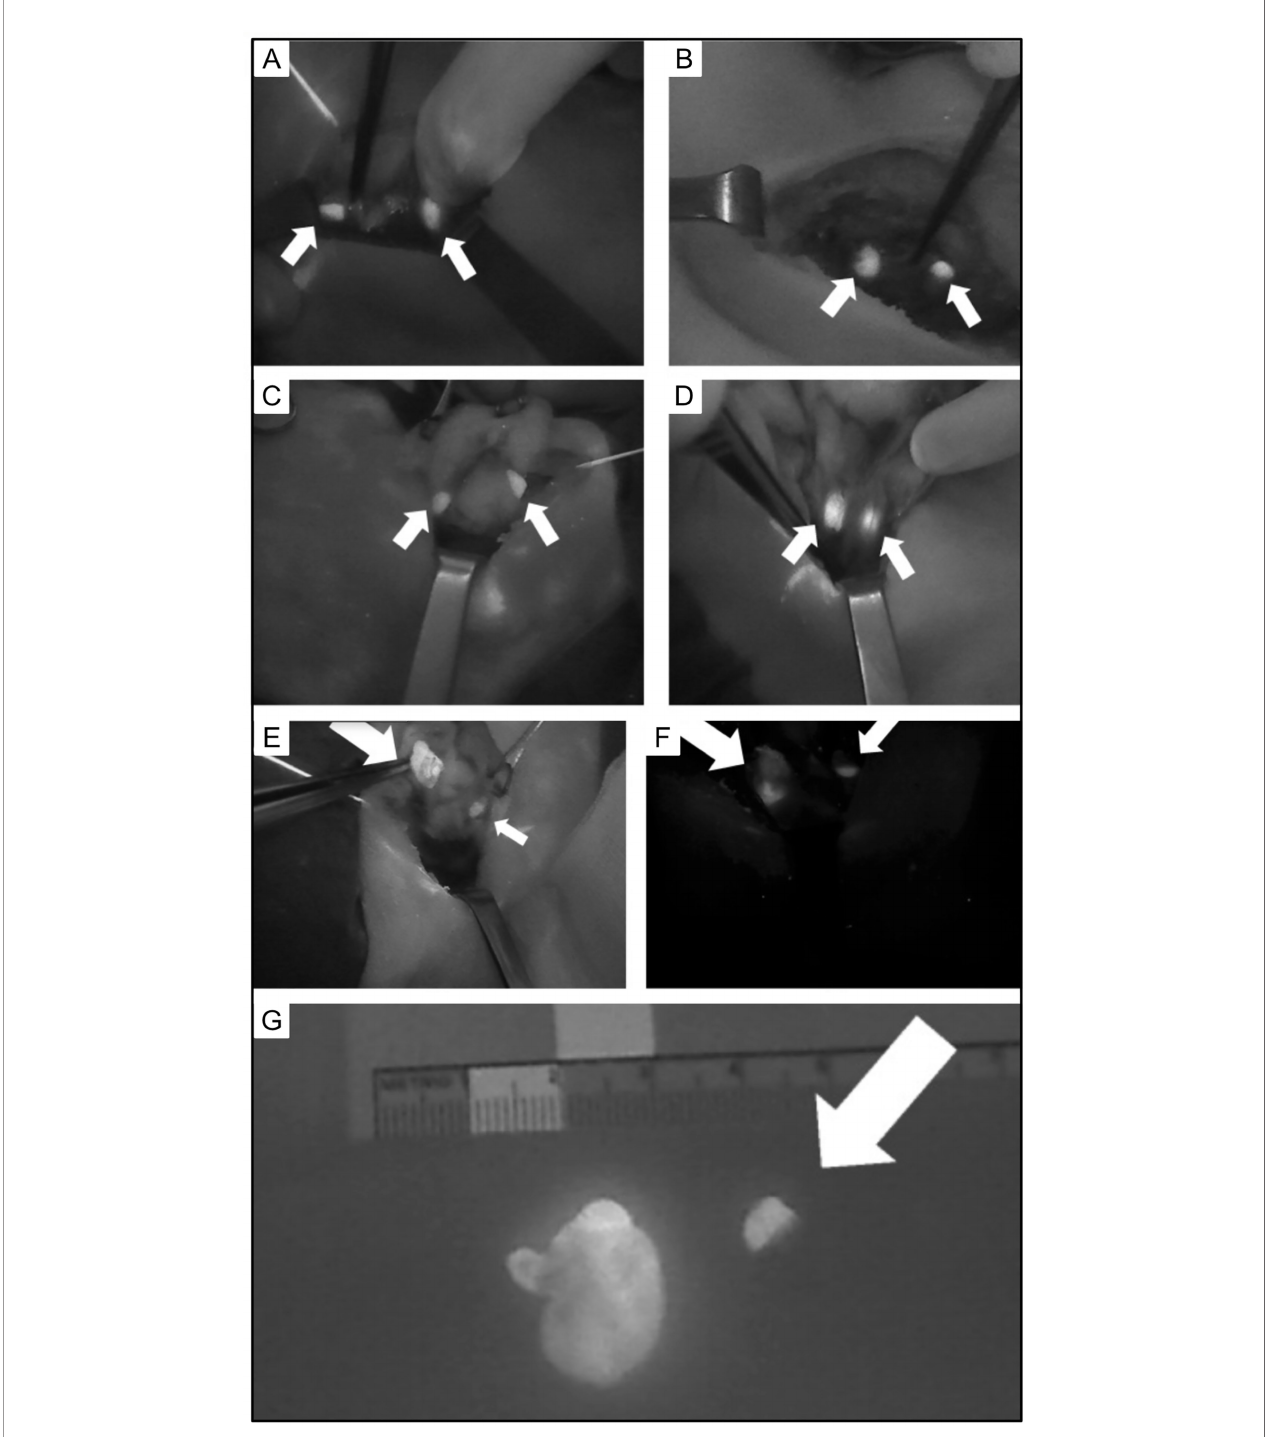
FIGURE 11 | Intraoperative views of parathyroid glands (PG) visualized using auto fl uorescence (small arrows). (A) Two PG following left thyroid lobectomy. (B) Two PG following right thyroid lobectomy. (C) Two PG following superior pole dissection with medialization of left thyroid. (D) Two PG after superior pole dissection with medialization of the right thyroid. (E) Superior right PA and (F) inferior left PA with heterogeneous fl uorescence pattern and enlargement (large arrow) compared to normal PG (small arrow). (G) Excised parathyroid adenoma with heterogeneous fl uorescence pattern and enlargement (left) compared to normal PG (right, arrow). Reproduced with permission from: Demarchi, M. S., Karenovics, W., Bedat, B., & Triponez, F. (2020). Intraoperative Auto fl uorescence and Indocyanine Green Angiography for the Detection and Preservation of Parathyroid Glands. Journal of Clinical Medicine Research, 9(3). https://doi.org/10.3390/jcm9030830